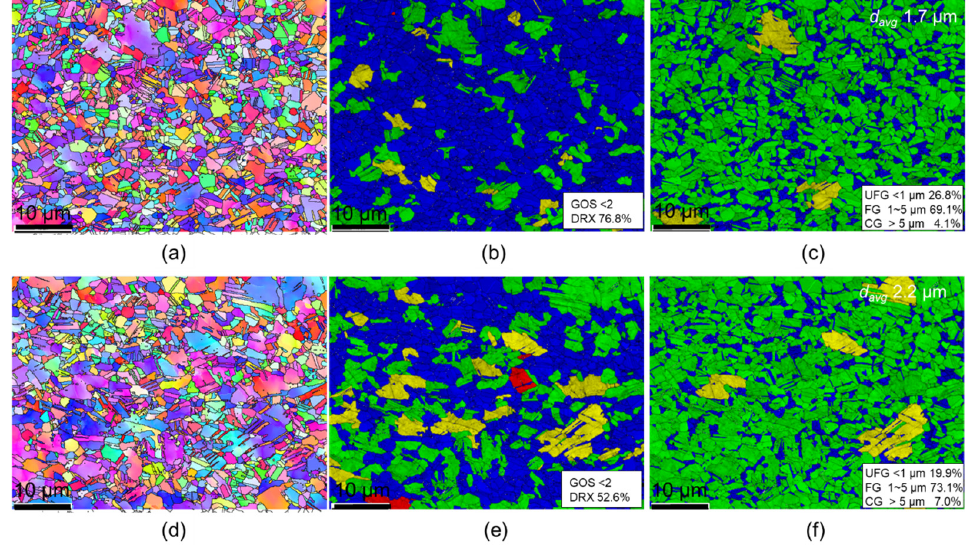
Figure 4. EBSD-IPF ( a , d ), GOS ( b , e ), and grain size ( d , f ) maps of the FG/CG-1 ( a – c ) and FG/CG-1 ( d – f ) samples deformed at a strain of 20%.